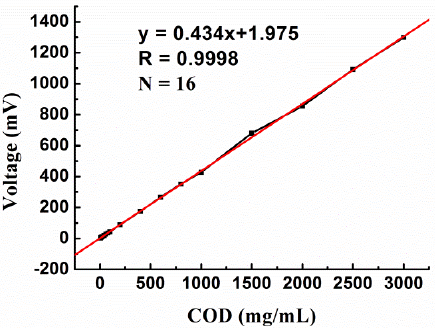
Figure 7. Calibration curve showing the linear range of the biosensor with respect to 350 μL glucose samples.